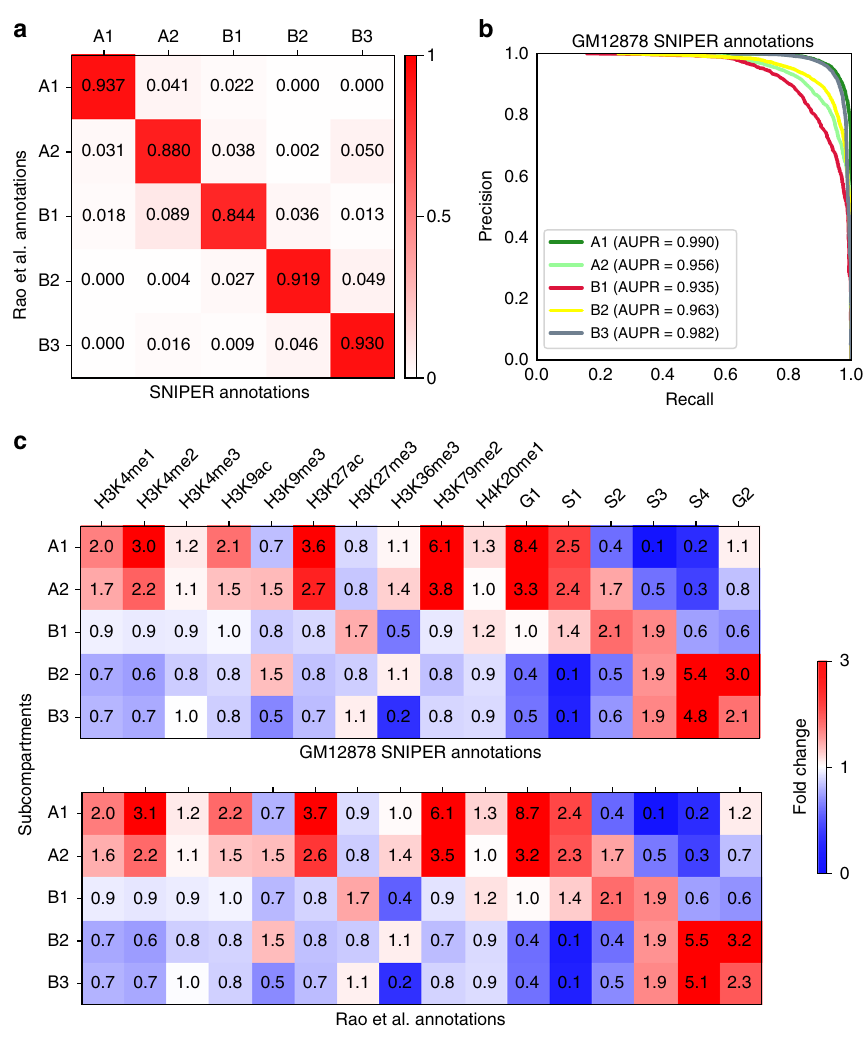
Fig. 2 SNIPER performance in GM12878. a Confusion matrix between SNIPER predictions and the original subcompartment annotation based on the high- coverage Hi-C in Rao et al. 5 . b Precision-recall curve and AUPR values for the prediction of each subcompartment. c Histone mark and replication timing fold change pro fi les constructed for SNIPER results (top) and the Gaussian HMM subcompartment calls based on the full dataset 5 (bottom). Fold change of an epigenetic mark in each subcompartment is de fi ned as the median signal of the mark divided by the median signal across all subcompartments. Source data are available in the Source Data fi le